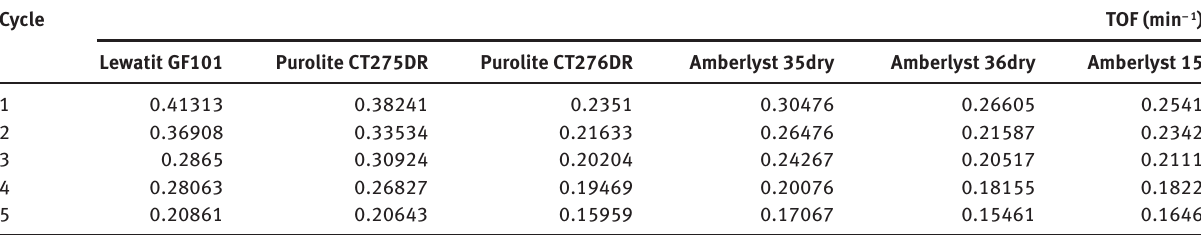
Table 3: Evolution of turnover frequency (TOF) of the resins with recycling experiments at 313 K, M = 4.5 and catalyst load of 0.5% w/w.